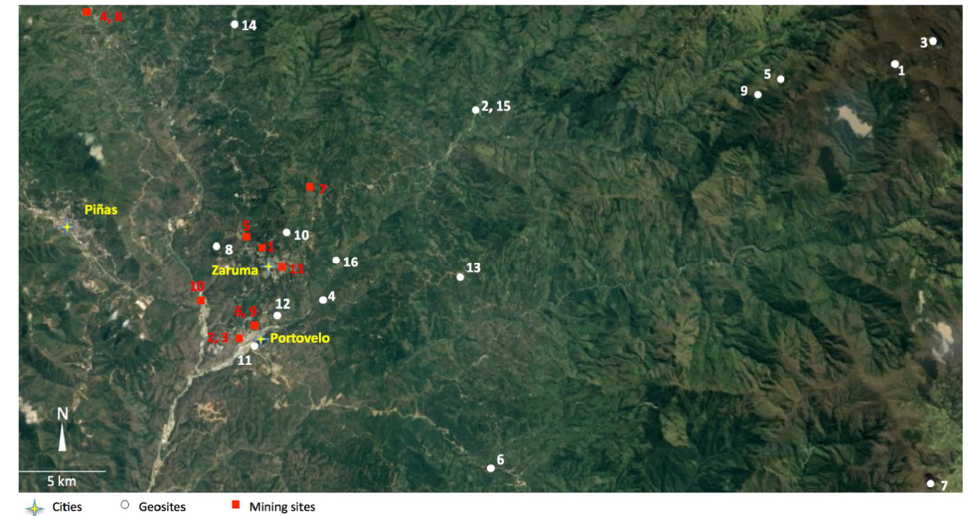
Figure 4. Location of the geosites and mining sites identified in the Zaruma-Portovelo mining district. [36].